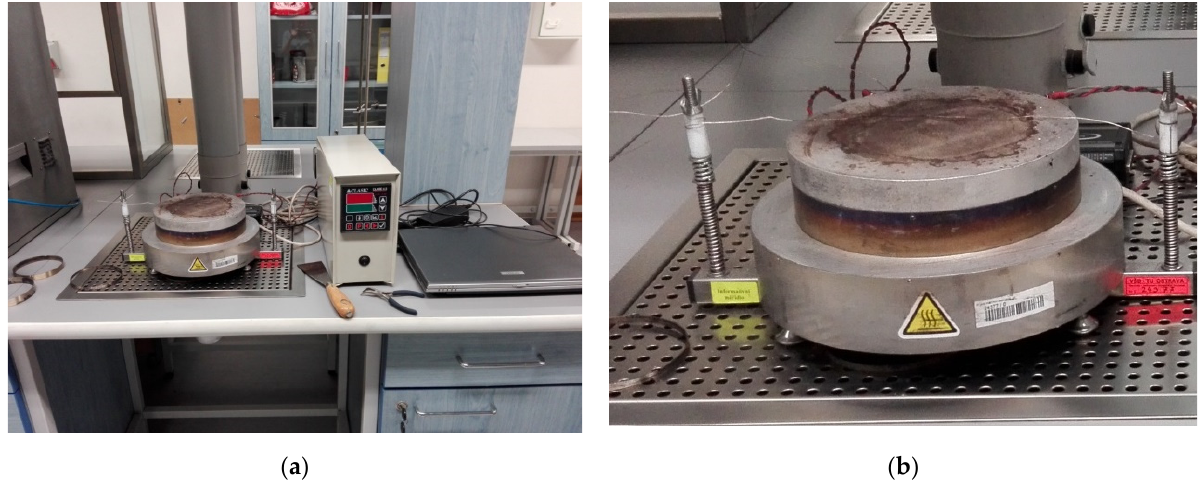
Figure 2. ( a ) Measuring apparatus; ( b ) hot-plate equipment by EN 50281-2-1: 2002